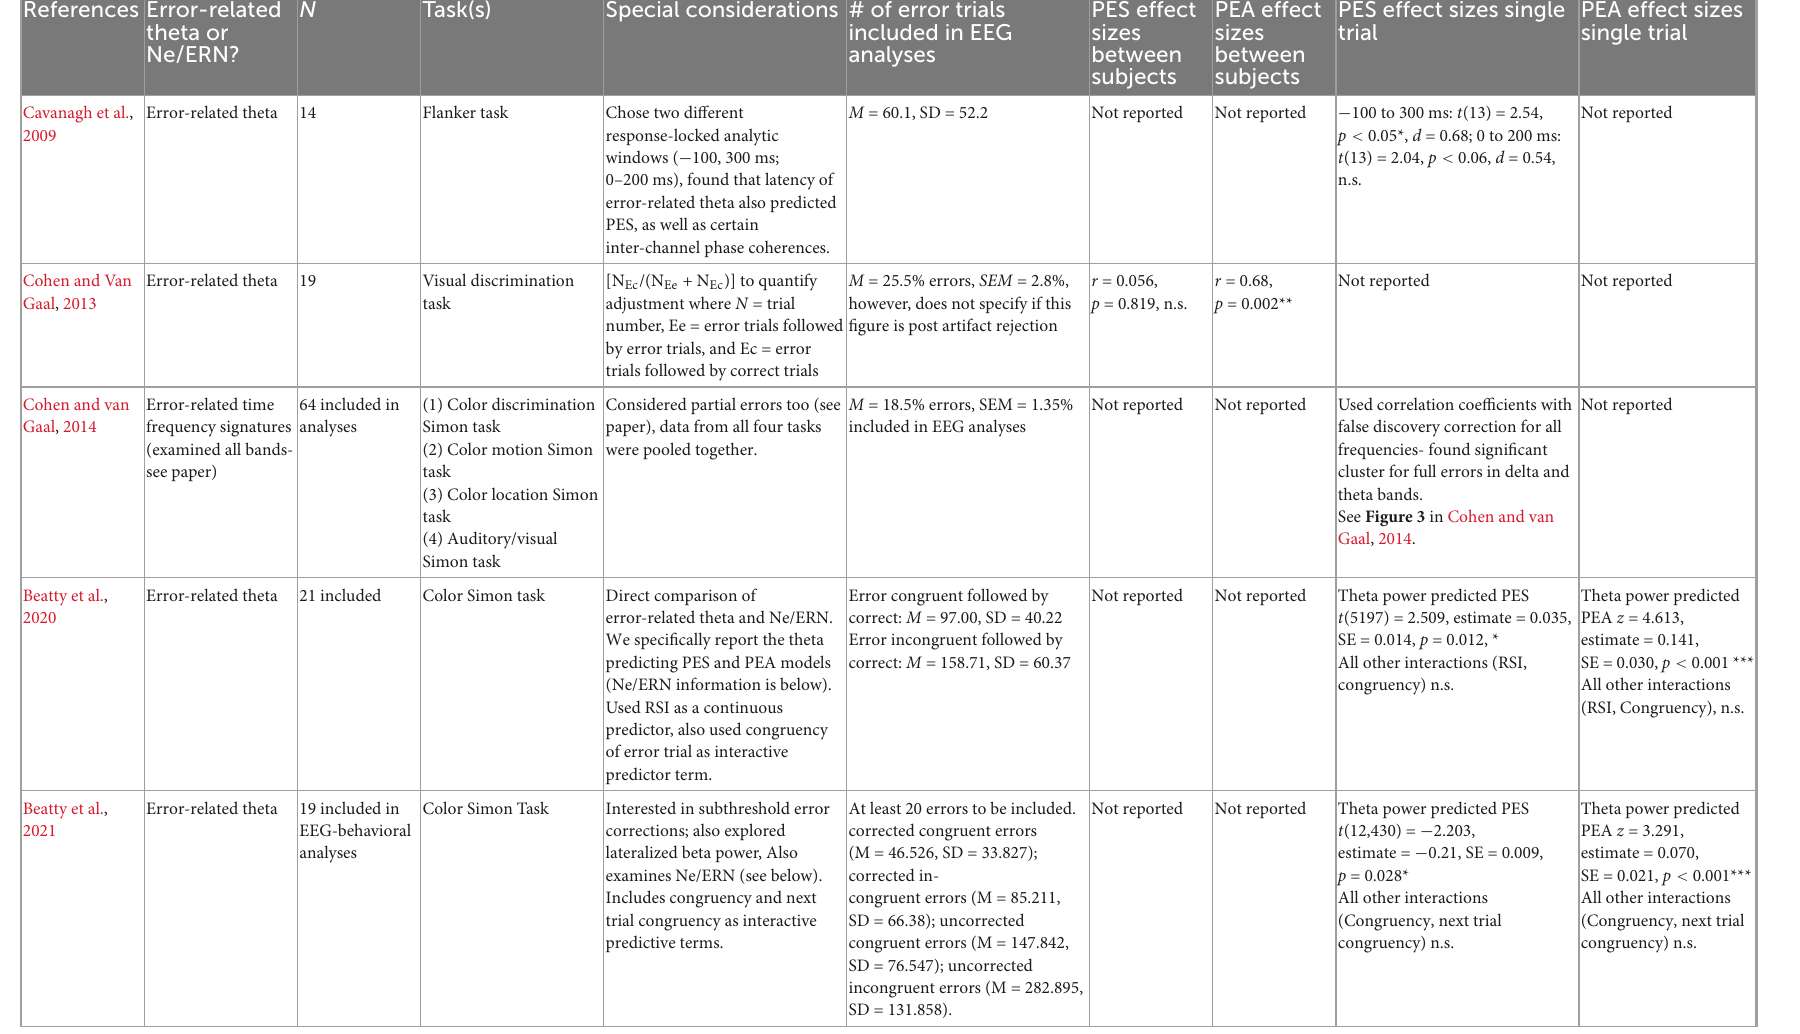
TABLE 1 A review of the literature surrounding relationships between error-related theta/Ne/ERN activity and post-error adjustment. References Error-related theta